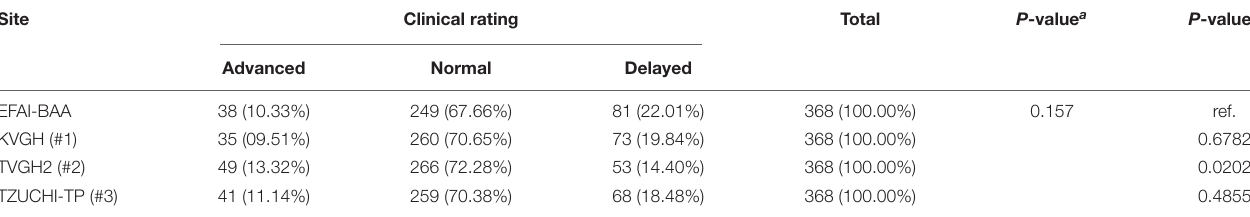
TABLE 3 | Differences in the clinical rating (secondary endpoint) between three physicians and EFAI-BAA. Site